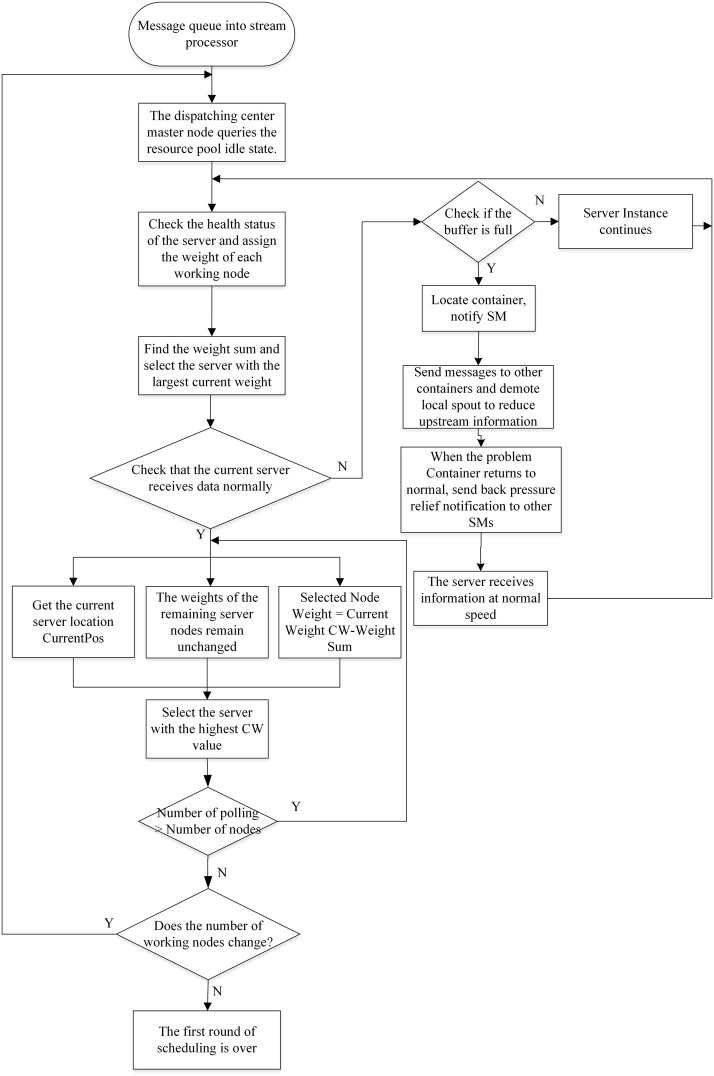
Data processing at server nodes.